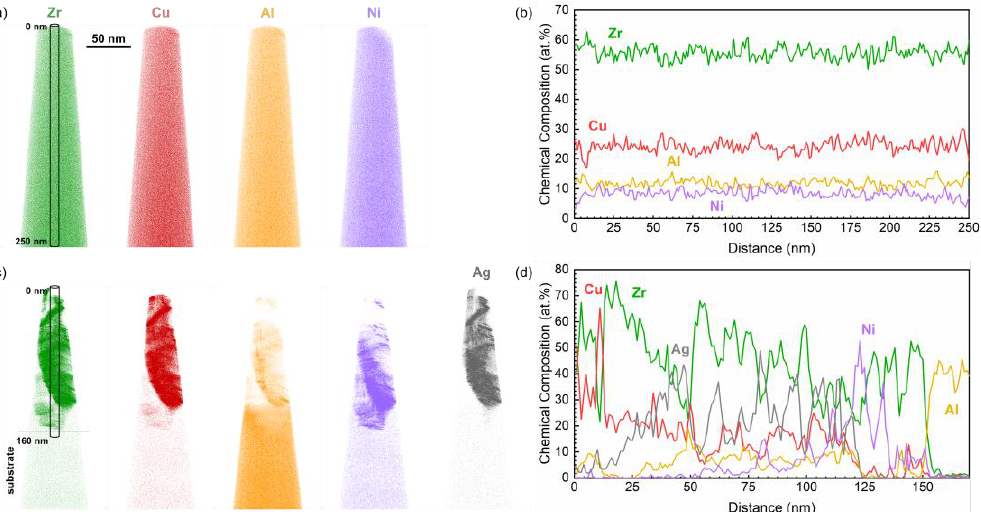
Figure 6. ( a ) Elemental reconstruction of Zr, Cu, Al, and Ni positions, and ( b ) concentration profile of the cylindrical region indicated in ( a ), of the pure TFMG, deposited without bias at 60 °C. ( c ) Reconstruction of Zr, Cu, Al, Ni, and Ag positions, and ( d ) concentration profile of the cylindrical region indicated in ( c ), of the TFMG containing 30 at.% Ag, deposited without bias at 60 °C.